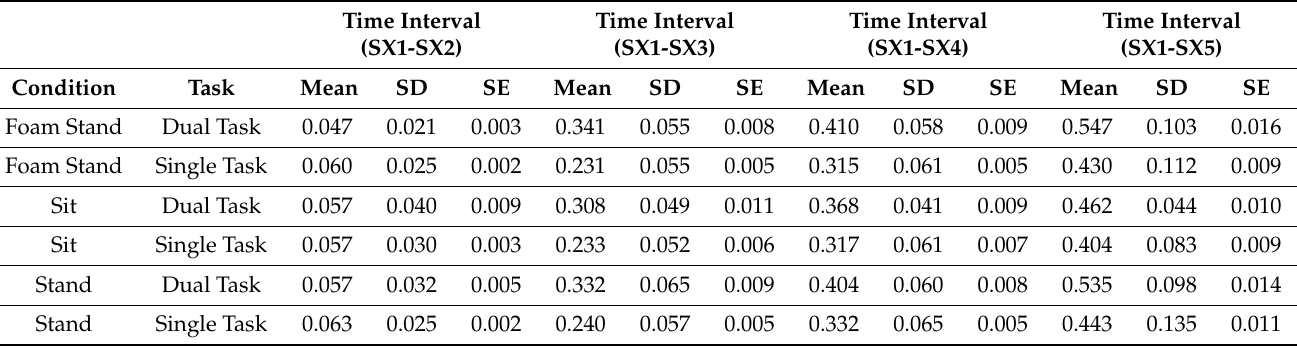
Table 3. Identification of drop stick events (SX1, SX2, SX3, SX4, SX5) during the fall and time interval between the events. The time interval between SX1-SX2, SX1-SX3, SX1-SX4, and SX1-SX5 are reported for single and dual